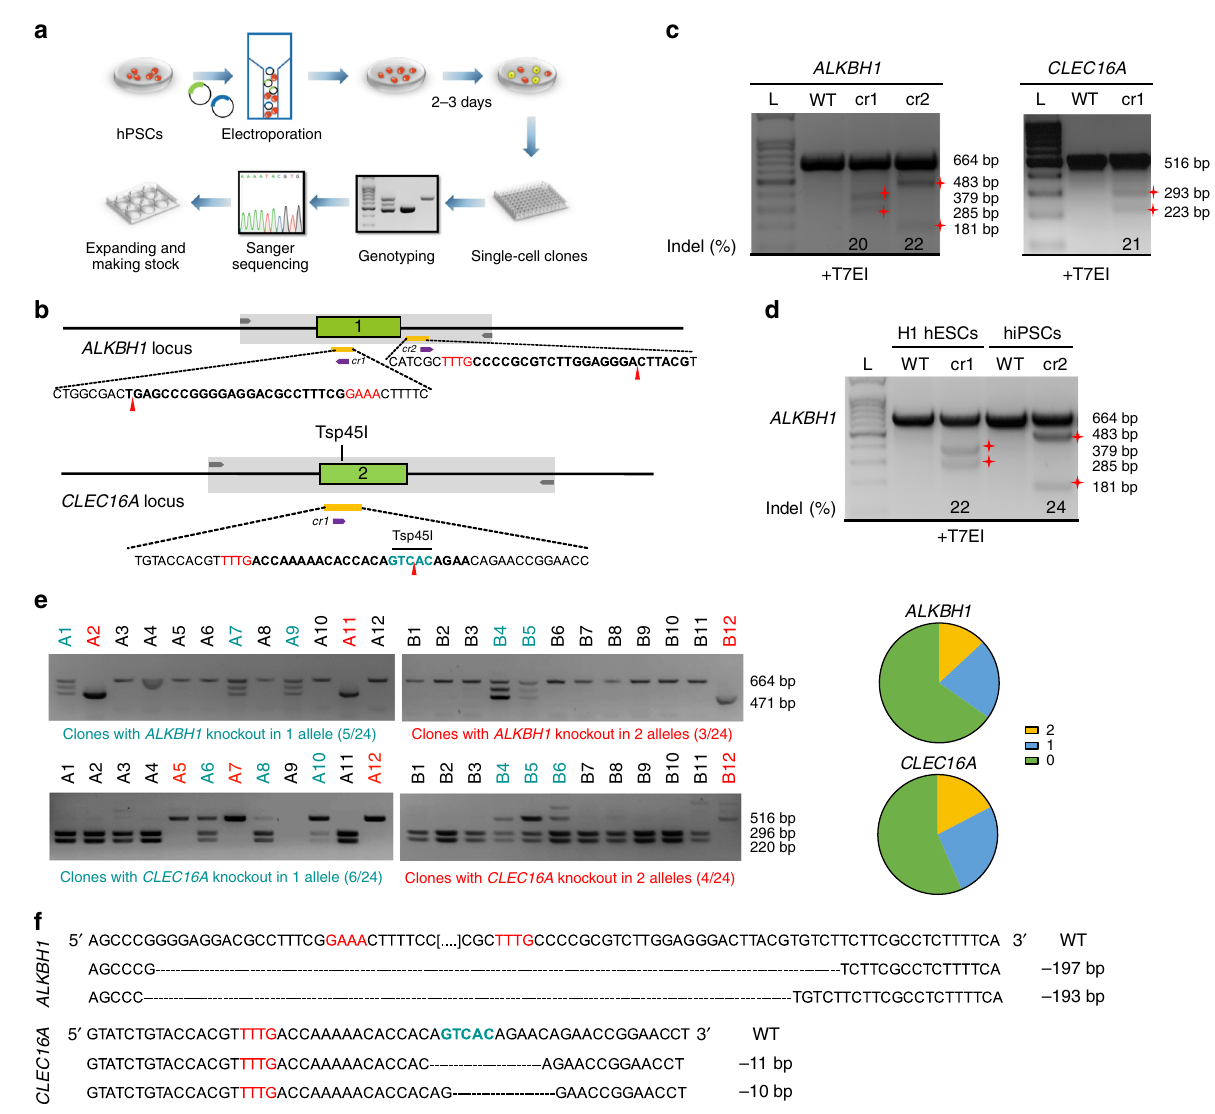
Fig. 1 Ef fi cient generation of knockout hPSC lines using CRISPR-Cpf1. a A scheme of the experimental procedure for generating knockout hPSC lines. b Schematic of Cpf1 crRNA targeting sites at ALKBH1 and CLEC16A loci showing exon structures (green boxes), PCR amplicons (light gray boxes), and restriction sites used for PCR analysis. crRNA targeting sequences are in bold; PAM sequences are in red. c T7EI assay for crRNAs of ALKBH1 and CLEC16A in MEL1 hESCs. The Indel frequency was calculated using the expected fragments. d T7EI assay for crRNAs of ALKBH1 in H1 hESCs and hiPSCs. The Indel frequency was calculated using the expected fragments. e PCR analysis upon crRNA transfection. For ALKBH1 , two crRNAs were transfected together. Clones with gene knockout in one allele are in blue, and clones with gene knockout in two alleles are in red. More detailed description and explanation of the band pattern can be found in Supplementary Fig. 2. f Sequencing results of the targeted allele in ALKBH1 and CLEC16A knockout hPSC lines. PAM sequences are in red. Restrictive enzyme site is in